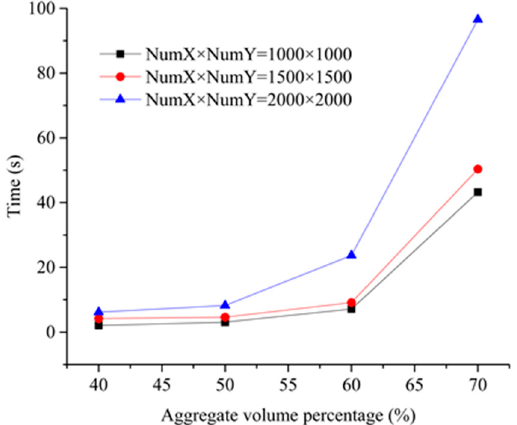
Figure 18. Execution time of aggregate placement with different aggregate volume fractions under different dot matrices.